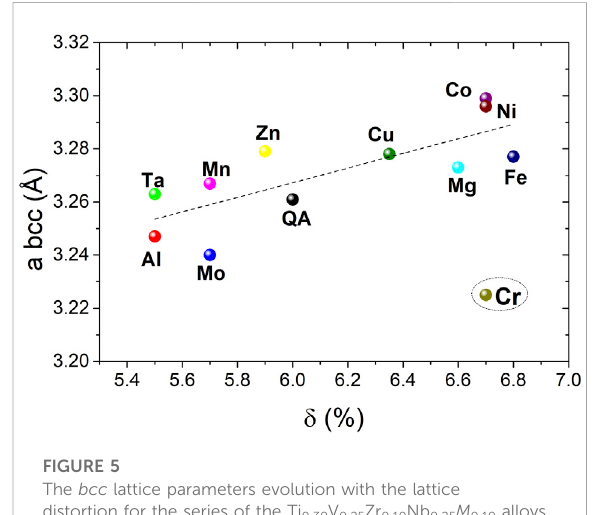
FIGURE 5 The bcc lattice parameters evolution with the lattice distortion for the series of the Ti 0.30 V 0.25 Zr 0.10 Nb 0.25 M 0.10 alloys with M = Mg, Al, Cr, Mn, Fe, Co, Ni, Cu, Zn, Mo, and Ta. QA designates the quaternary alloy whereas the quinary compositions are marked with the M element.